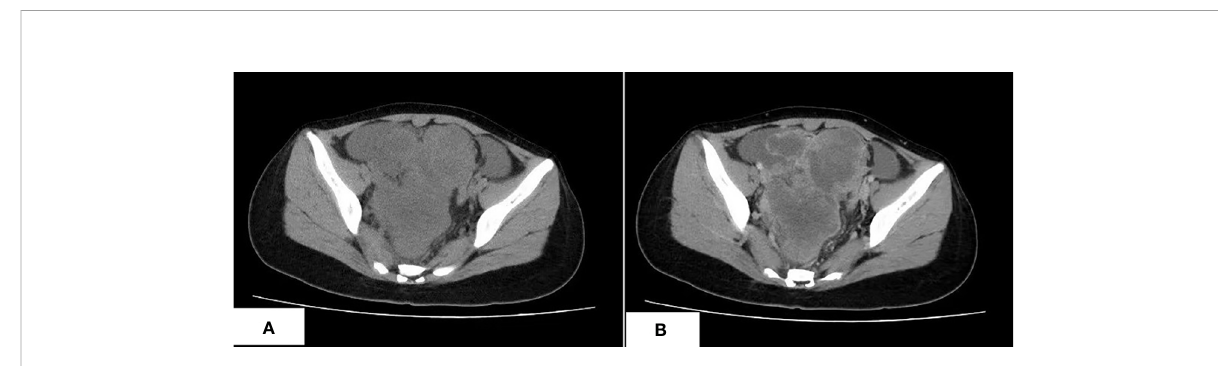
FIGURE 1 The CT scan of CDS. (A) An irregular lobulated mass in pelvic cavity, which has unclear margin with peripheral structure, is shown. (B) The tumor shows heterogeneous enhancement in the contrast-enhanced CT